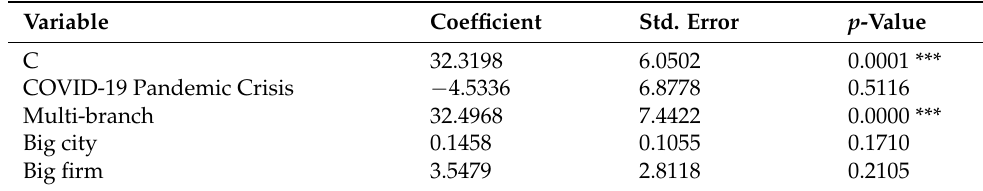
Table 7. The results of the sixth research